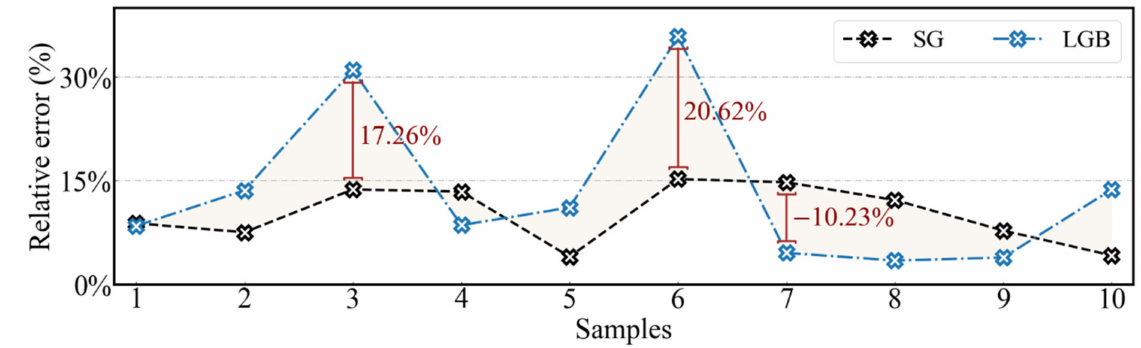
Figure 16. Comparison of relative errors between SG and LGB for validation